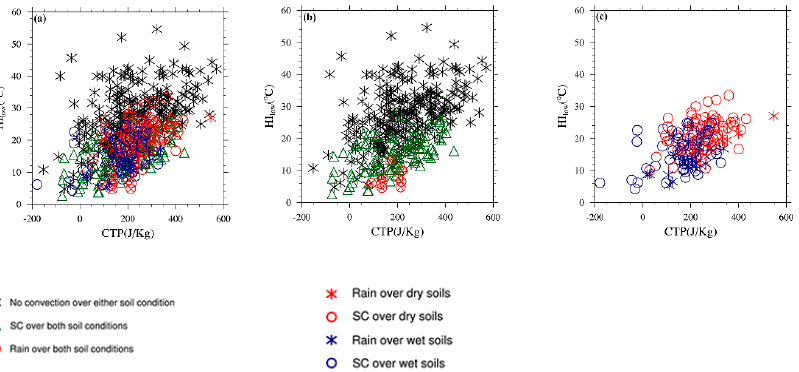
Figure 6. The CTP — HI low distributions of five stations’ model outcomes in the Loess Plateau. Total cases: ( a ) atmosphere—controlled cases, ( b ) and soil moisture-controlled cases, ( c ) SC indicates shallow convection. Black boxes encircle wet soil advantage area and dry soil advantage area.